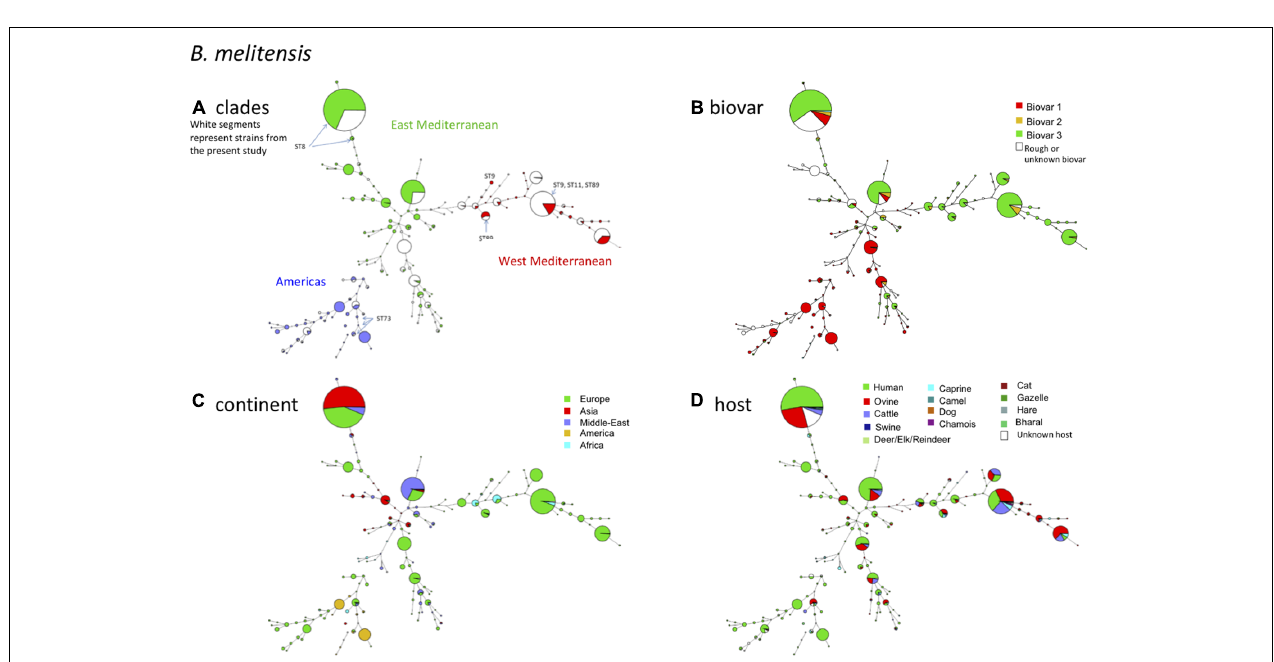
FIGURE 2 | B. melitensis intraspecies diversity view provided by MLVA11. 2320 among the 4971 entries with a full MLVA11 dataset belong to B. melitensis. 1049 entries are from this study, 17 are in silico entries (nine complete genomes and eight entries based on sequence reads archives) and 1254 are compiled from MLVA publications. The same MLVA11 minimum spanning tree was color-coded according to different characteristics. (A) Color coding according to assignment to East Mediterranean, West Mediterranean, or Americas groups except for strains typed in the course of the present study (white). The MLST21 genotypes deduced from whole genome sequence data are indicated. (B) Color-coding according to biovar (white when unknown). (C) Color-coding according to geographic origin defined at continent level. (D) Color-coding according to host (white when unknown).